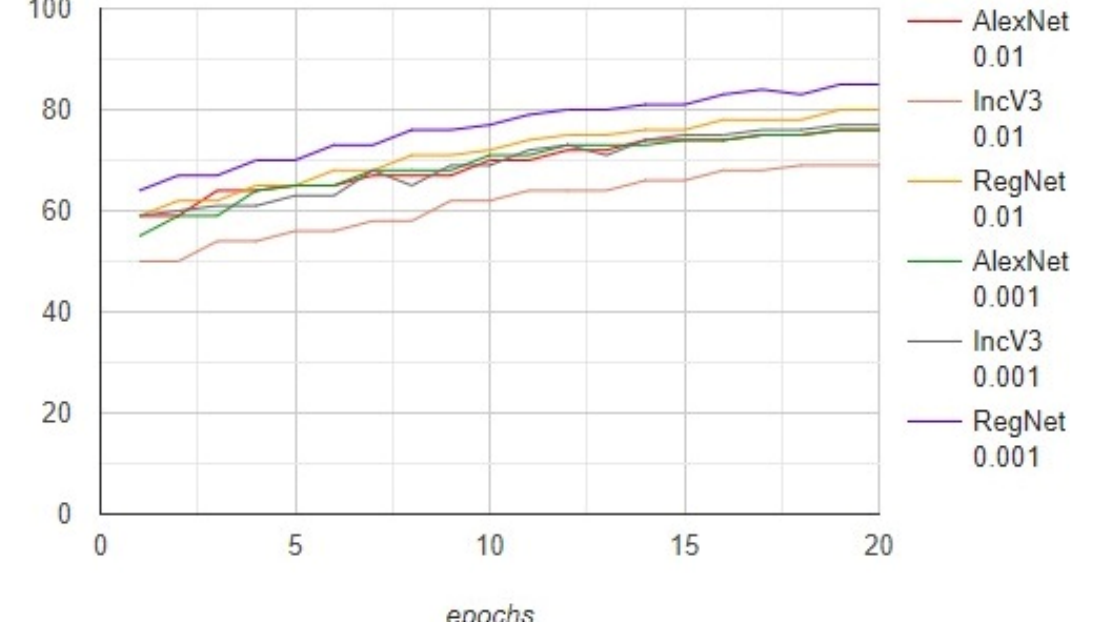
Table 2. Various configurations of the image augmentation method. Technique Configuration Rotation (Random)